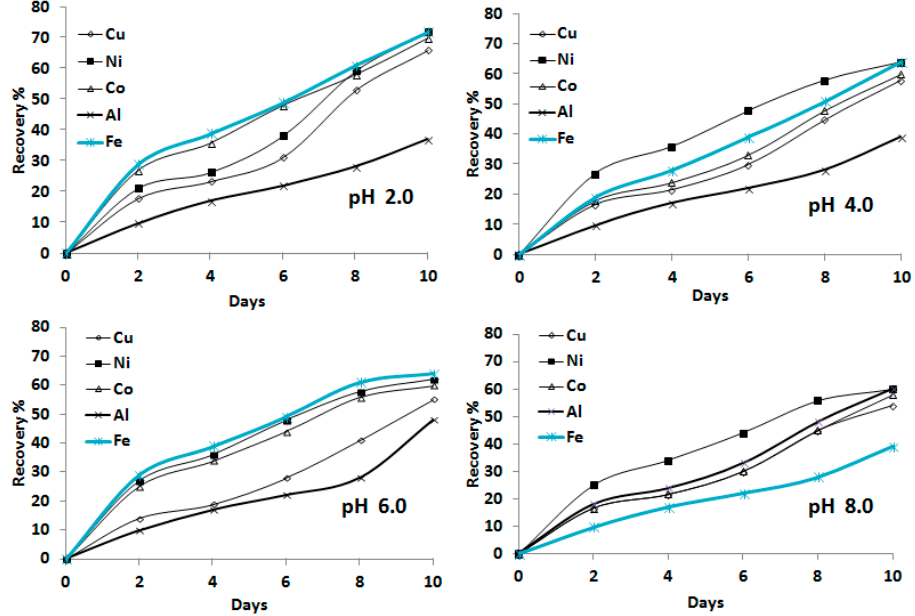
Figure 4. Metal recovery yields in various pH conditions during fungal leaching of PCB at 2% PD, 308 K.